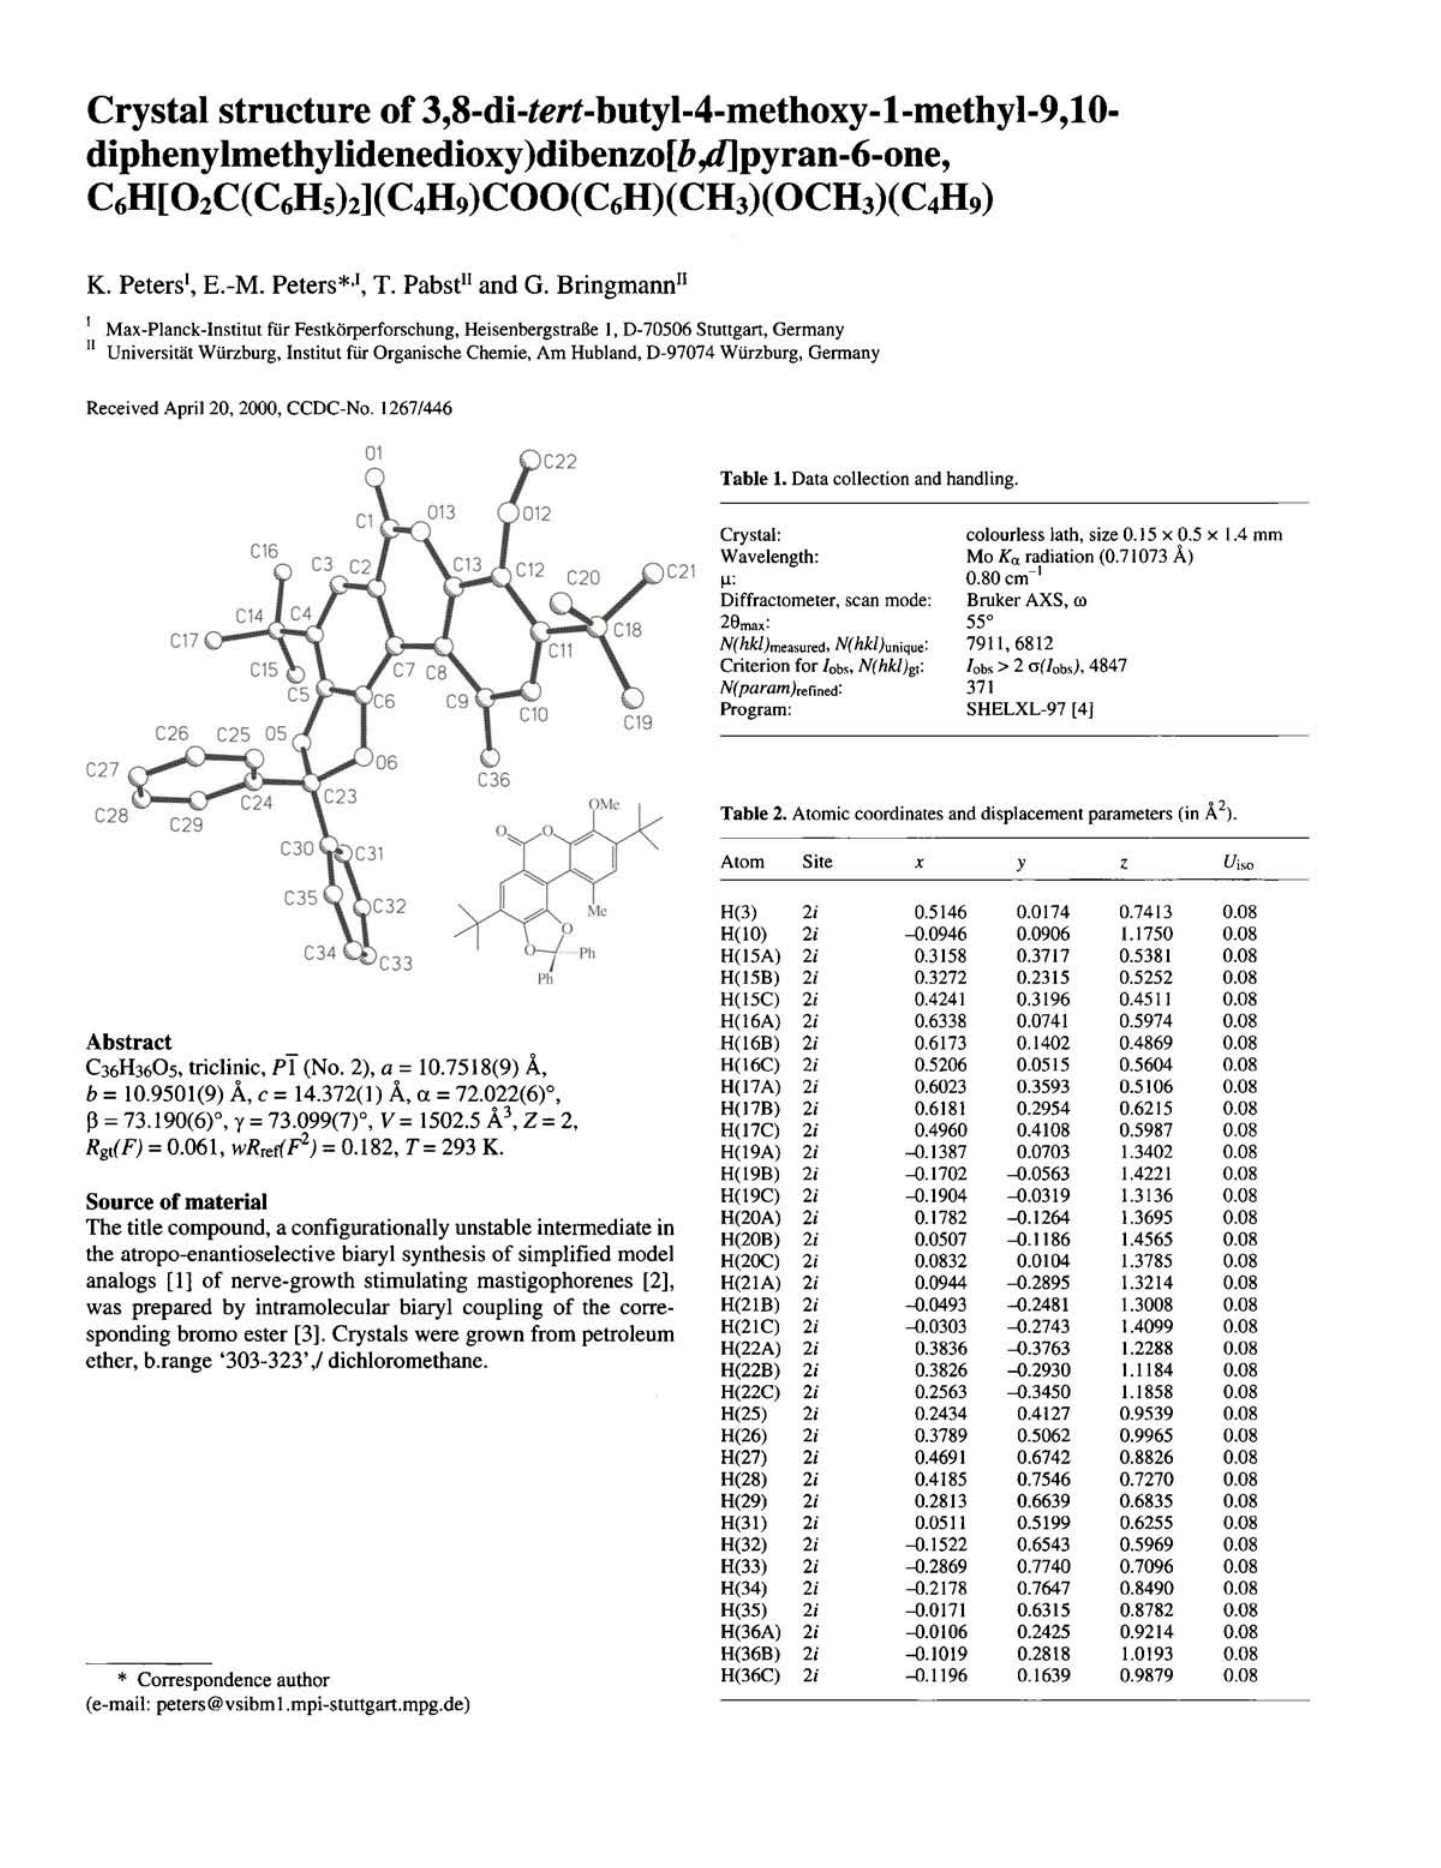
Table 1. Data collection and handling.